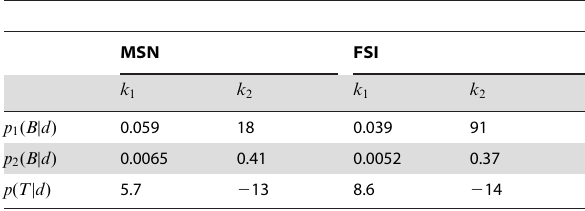
Table 2. Search results: final parameters for the MSN and FSI branch and termination probabilities, rounding to two significant